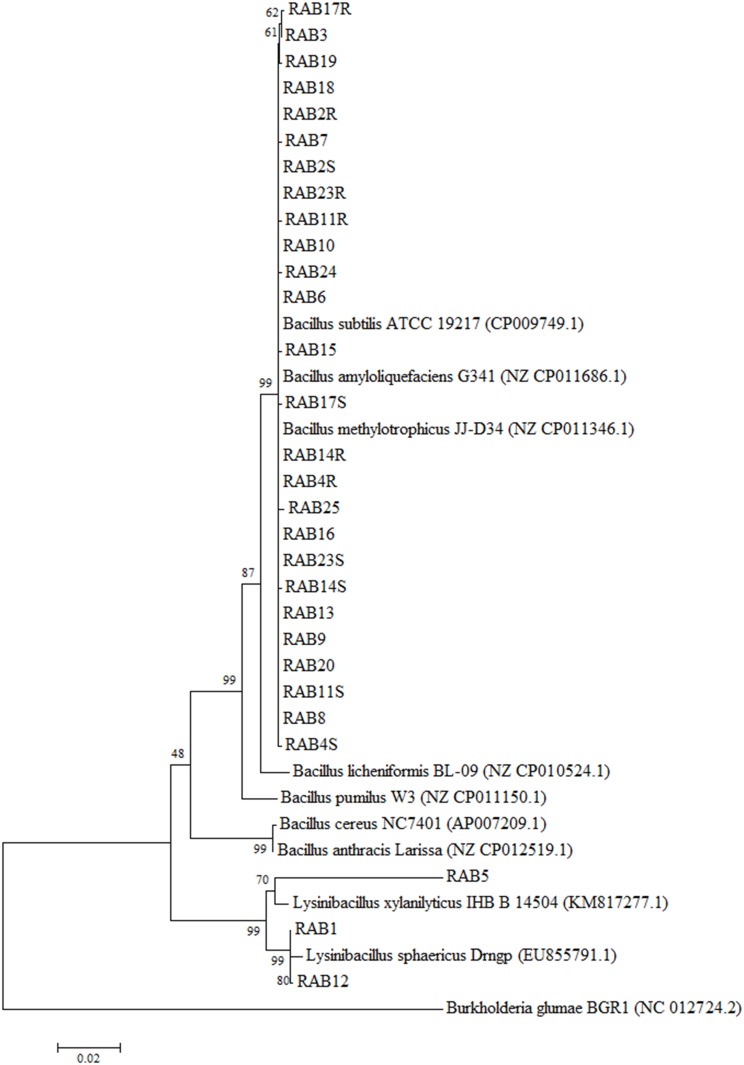
Phylogenetic tree based on 16S rDNA sequences of the 29 rice-associated bacteria (RABs) and other Bacillus species from GenBank nucleotide database.GenBank accession numbers for the sequences obtained from the database are given in parentheses. The tree was generated using neighbor-joining method, and genetic distances were calculated using the Kimura 2-parameter method using MEGA5 [76]. Numbers at nodes indicate percentage of occurrence in 1000 bootstrapping. The bar at the bottom of the tree indicates the scale for genetic distances. Burkholderia glumae 336gr-1 was used as an out-group control.